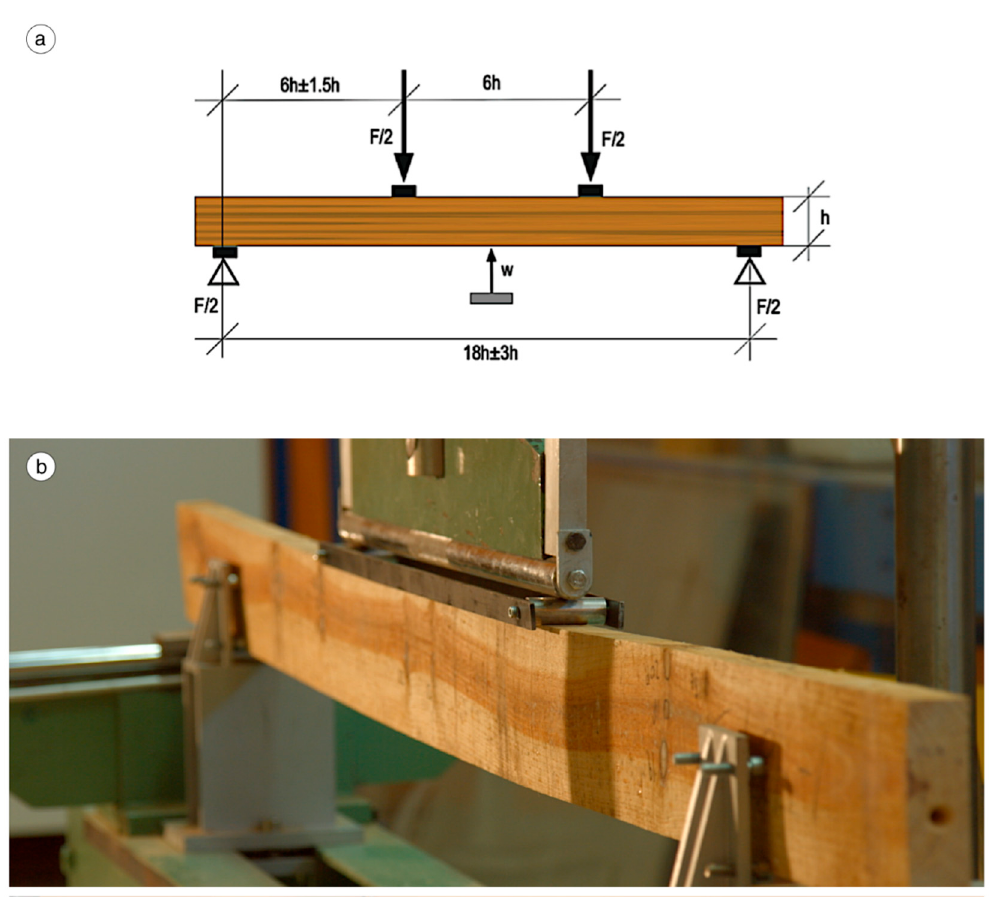
Figure 4. Bending test. ( a ) Diagram of EN 408 test [14] to determine modulus of elasticity (F: load applied, h: depth of cross-section, w: deformation); ( b ) piece under load.